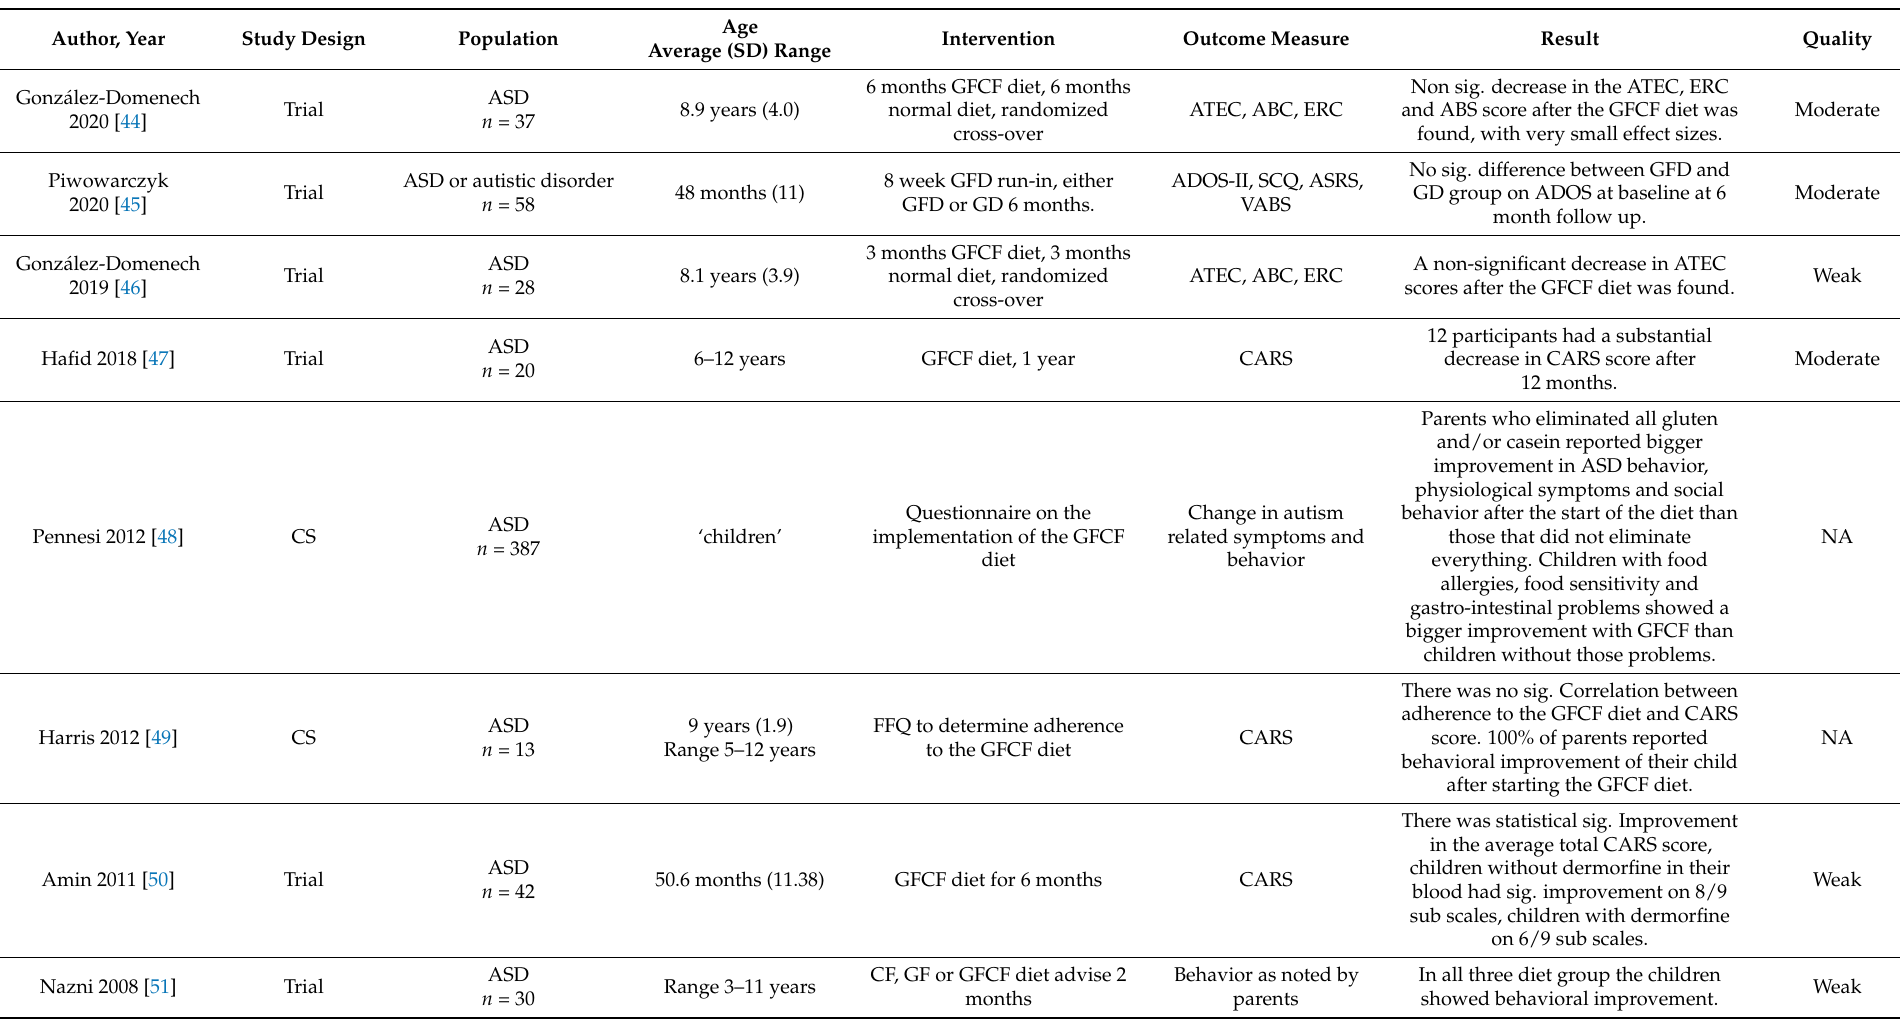
Table 3. Studies concerning therapeutic diets and specific food products for children with ASD, that are not included in the meta-analyses and systematic reviews in Table